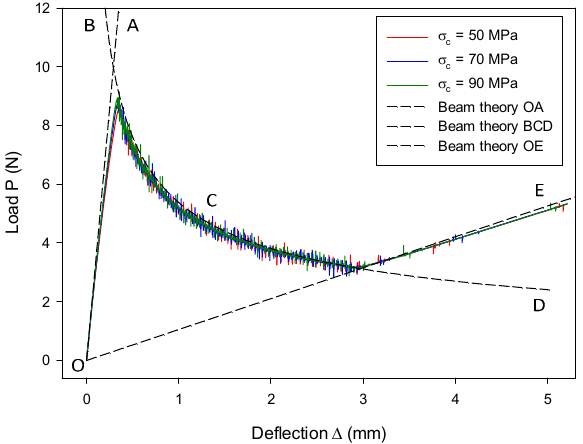
Figure 9. End load P as a function of deflection ∆ in the DCB model with different cohesive strengths.